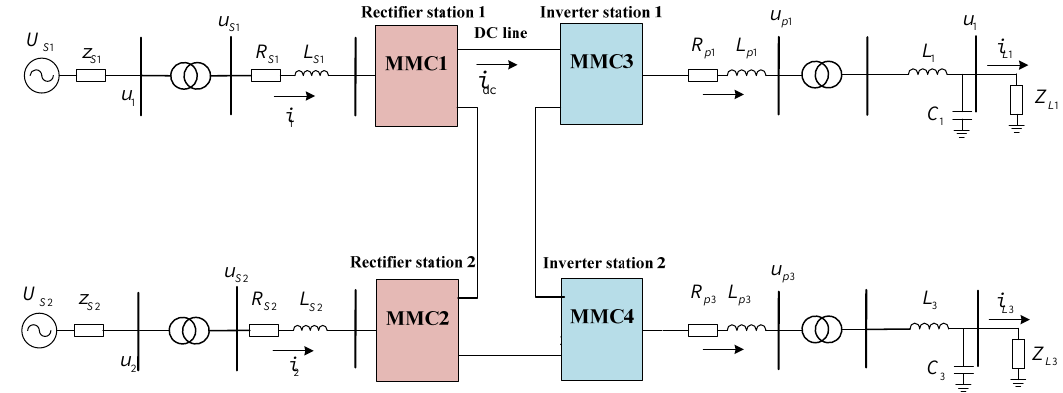
Figure 1. System configuration of a modular multilevel converter based multi ‐ terminal direct current (MMC ‐ MTDC) system for supplying passive networks.